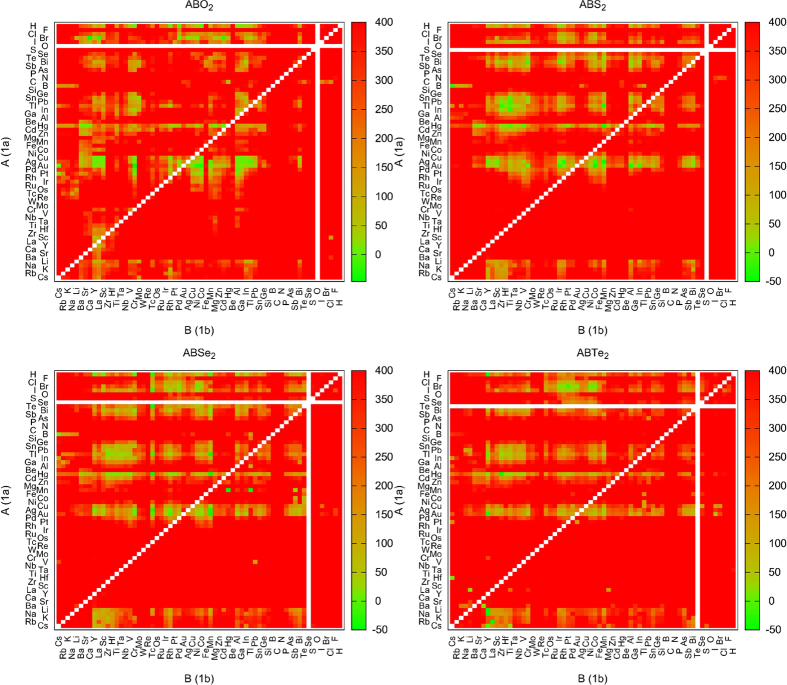
Stability maps for ABO2, ABS2, ABSe2 and ABTe2.The colors indicate the distance to the convex hull of stability (in meV per atom), with green meaning that the composition is thermodynamically stable. The order of the atoms along both axes follows an optimized Pettifor scale.